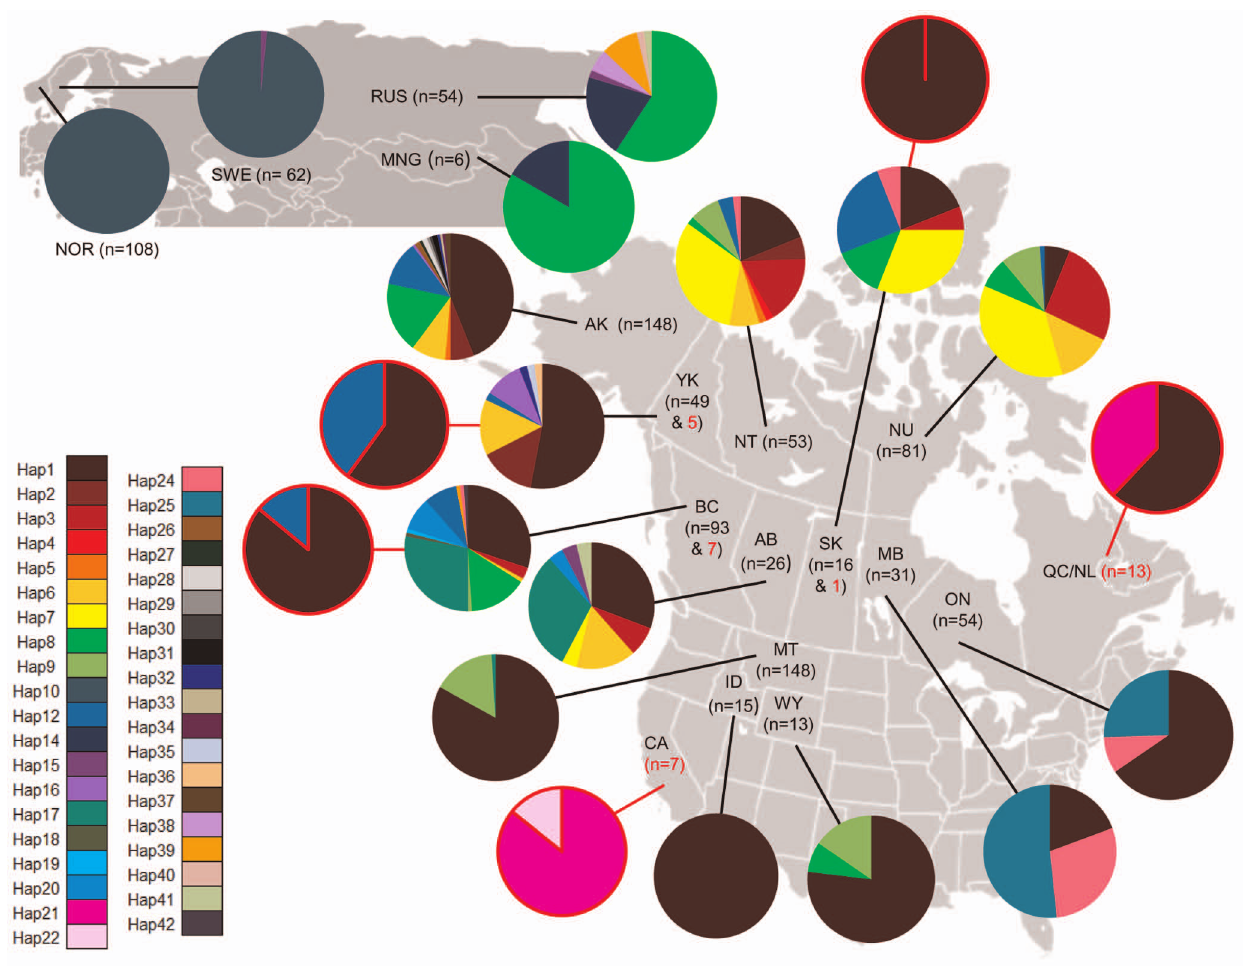
Figure 3. Geographical distribution of mtDNA haplotypes. The geographic distribution of mtDNA control region haplotypes based on frequencies observed for each region. Historic samples are presented separately and identified with a red border and red sample size number.